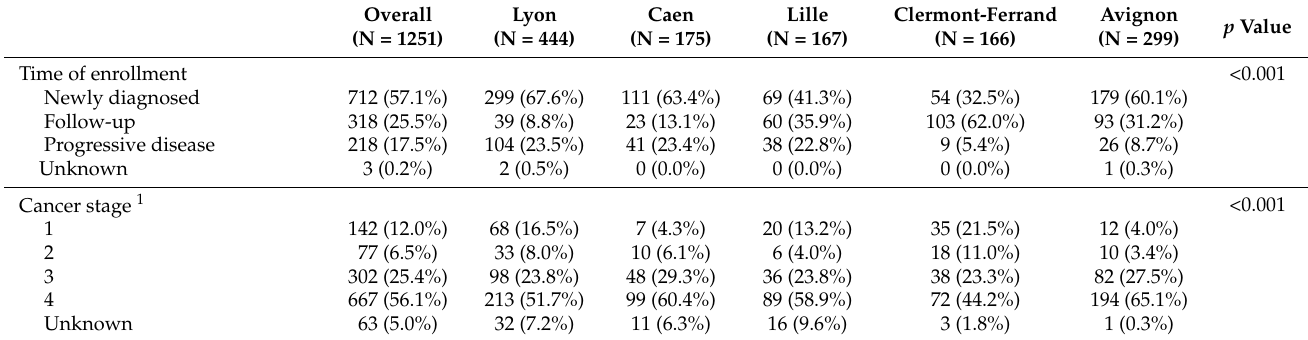
Table 2. Clinical characteristics of PROPOUMON national patients, globally and per